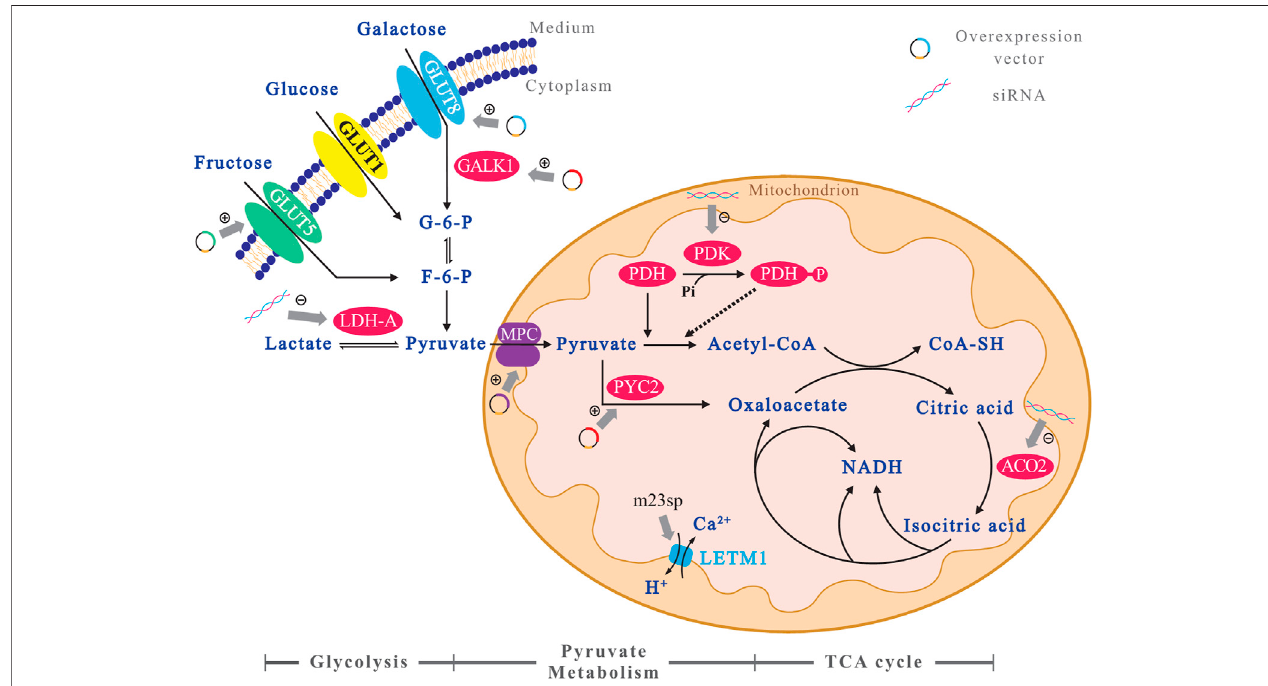
FIGURE 1 | A pro fi le of the GOIs ’ sites in the glucose metabolism pathway of CHO cells. To better demonstrate the relationship between the target genes of metabolic engineering and the glucose metabolism pathway in CHO cells, an illustration is presented. The GOIs which are overexpressed have been marked with “ +, ” and the others which are down-expressed via siRNA have been marked with “ − . ” All the GOIs are indicated using background of colorful circles, and the metabolic pathways are marked as an axis below the fi